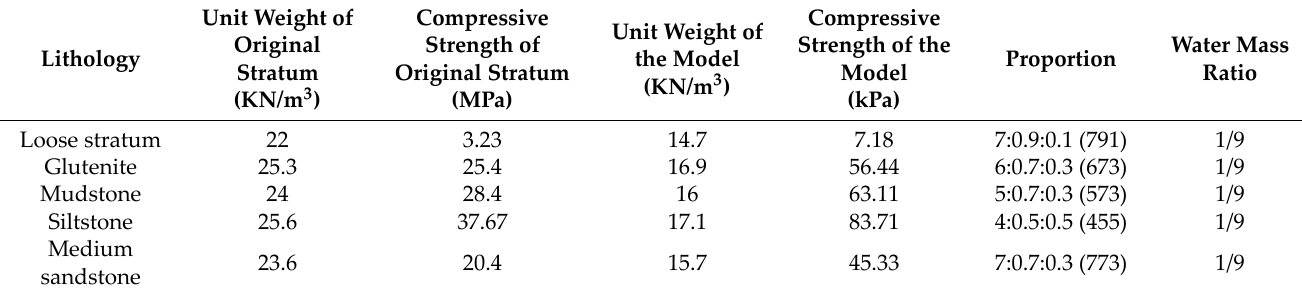
Figure 6. Tests performed on the samples: ( a ) view of the test samples, a group of three test samples from left to right are siltstone, mudstone, medium sandstone and sandy conglomerate; ( b ) uniaxial compressive strength measurement on the prepared test samples.